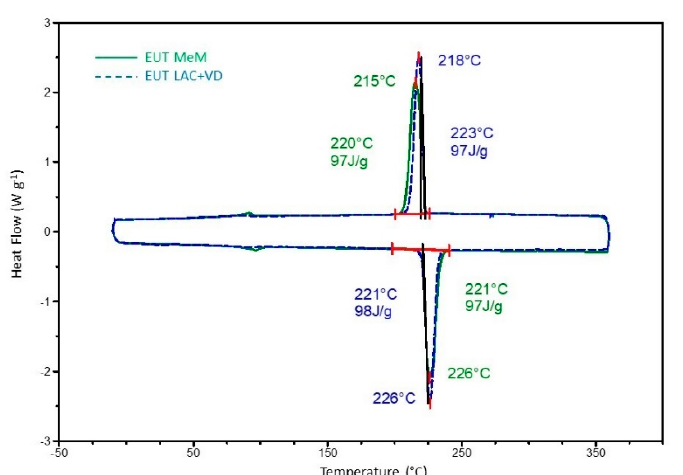
Figure 4. Comparison of DSC curves of the 2nd thermal cycle of eutectic produced with the synthesis in solvent LAC + VD and with the synthesis in melted MeM. The two peak temperatures T m , T c and enthalpies ∆ Hm, ∆ Hc are presented .